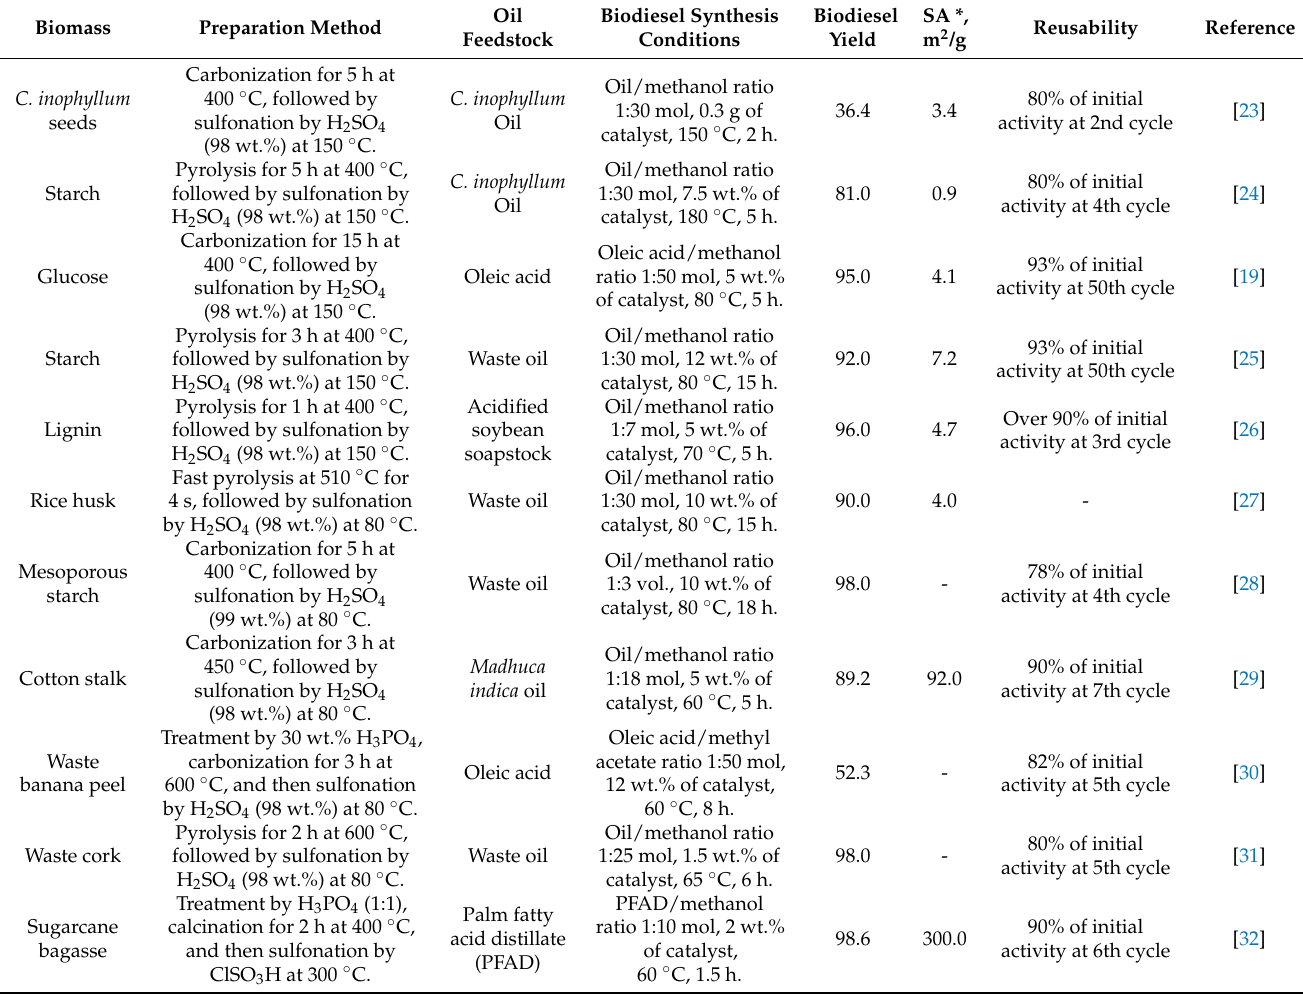
Table 1. Sulfonated carbon-based catalysts for biodiesel